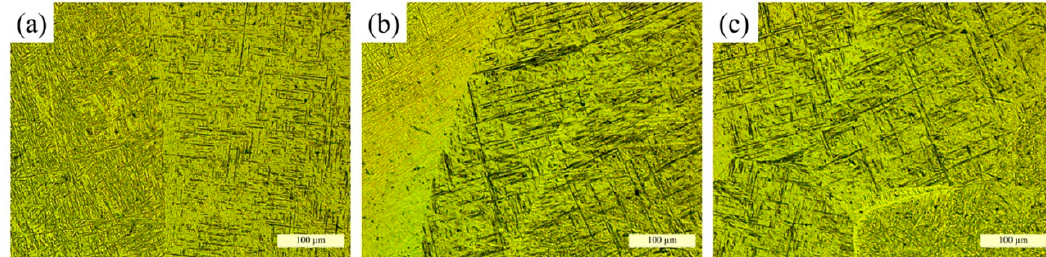
Figure 7. The microstructure of the seven-layers samples: ( a ) the colonies of coarsen columnar grains of the as-deposited sample, ( b ) the colonies of short columnar grains of the post-UIT sample, ( c ) the colonies of equiaxed grains of post-UIT sample.